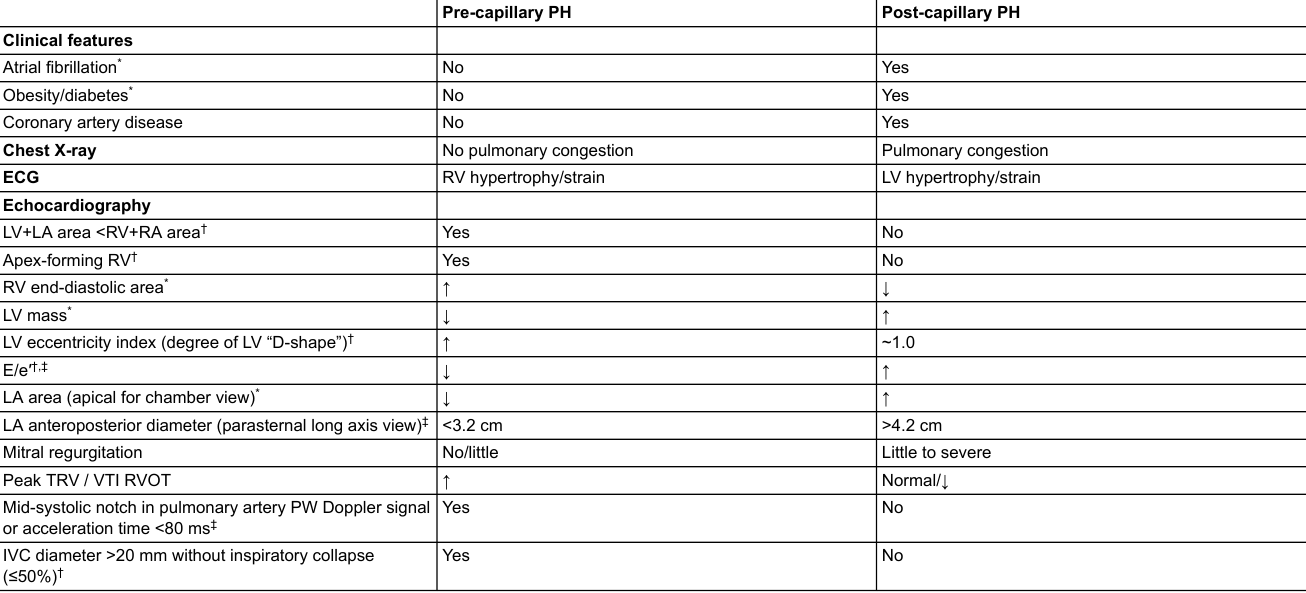
Table 1: Clinical features and non-invasive findings favouring precapillary or postcapillary pulmonary hypertension (PH). Pre-capillary